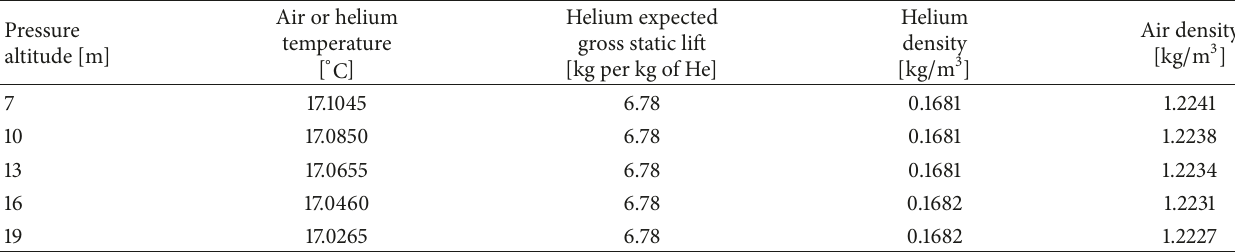
Table 7: Lifting properties of He in standard (ISA) operating conditions.